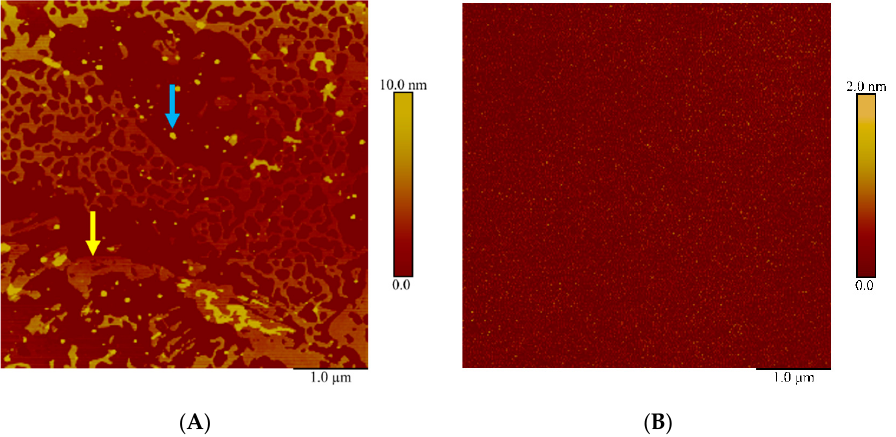
Figure 3. Typical AFM images obtained after incubation of DSP-activated ( A ) and non-activated ( B ) APTES-modified mica in 10 − 9 M HRP solution. Yellow arrow indicates the fragment of a layer-like structure, and blue arrow indicates aggregate structures, which have been attributed to layers of immobilized HRP molecules, since no such objects were observed in control experiments.